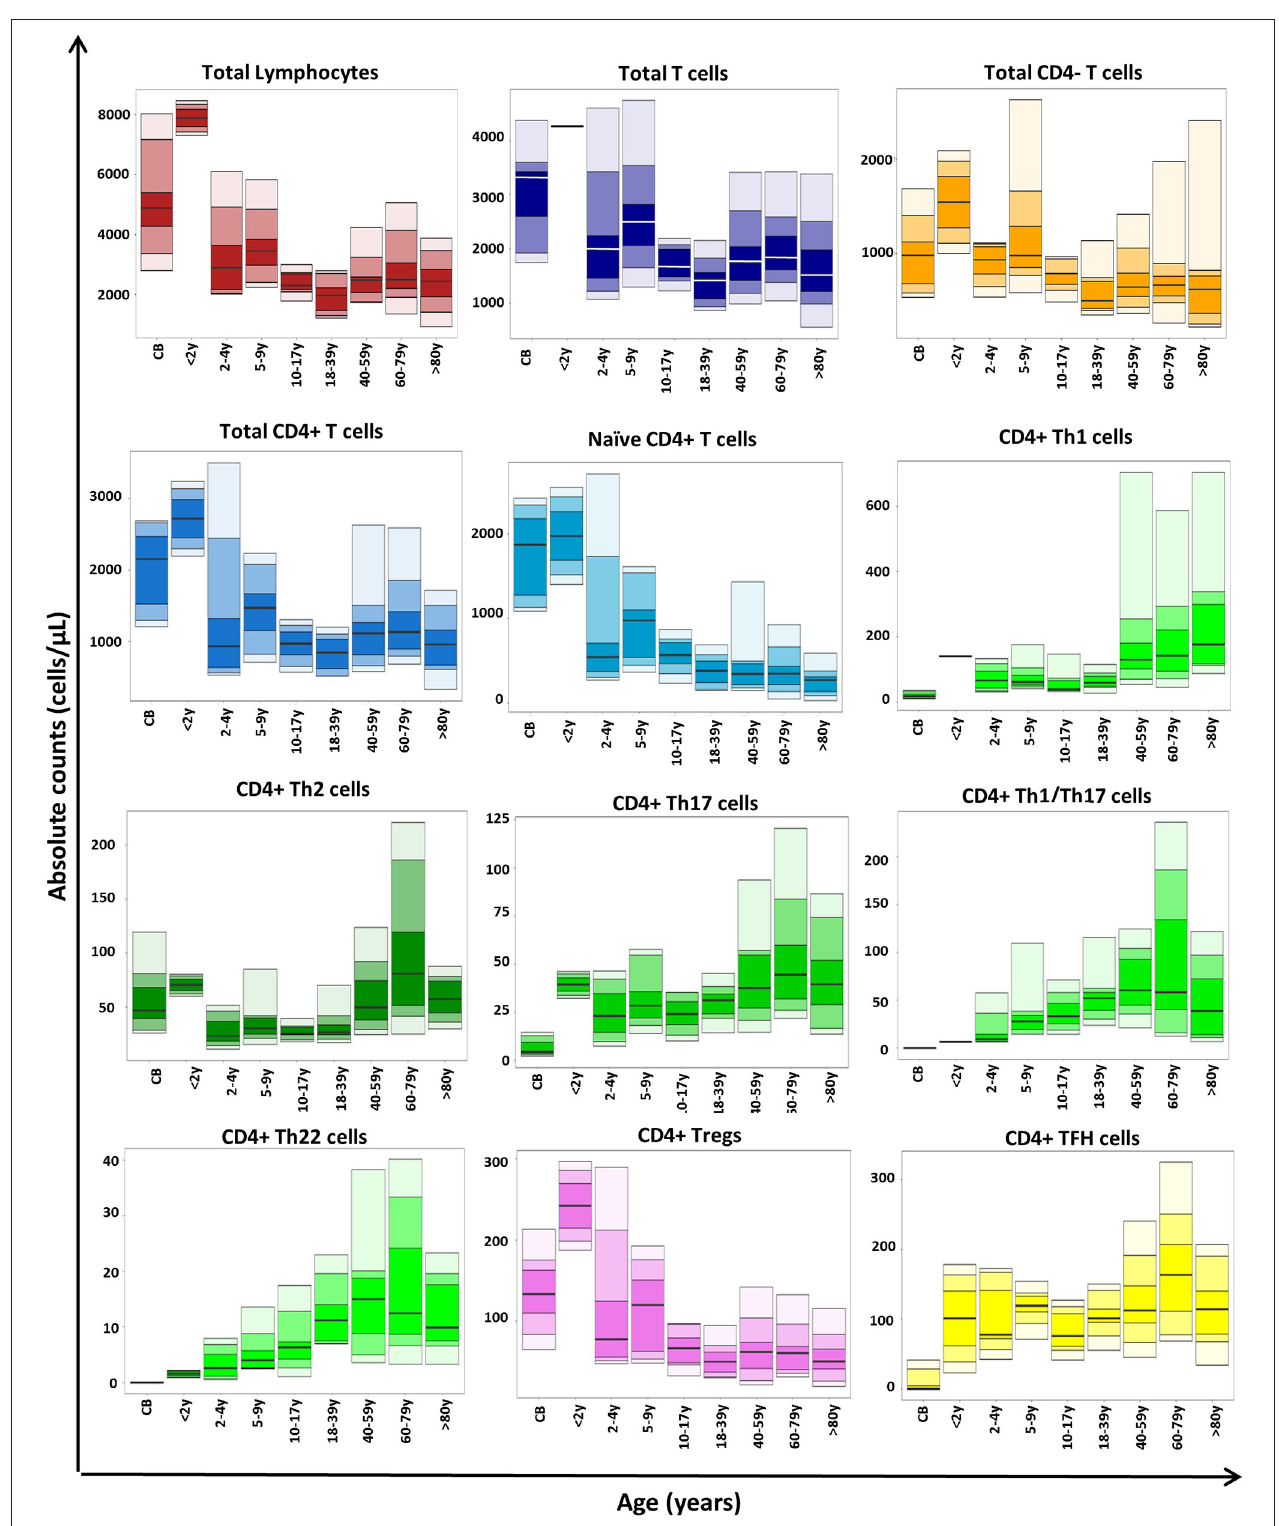
FIGURE 4 | Age-related distribution of CD4 + T-cell subsets in blood as assessed by the EuroFlow immune monitoring (IMM) TCD4 tube in 113 healthy controls. Absolute cell counts are displayed as bars representing median (p50 percentile), minimum, maximum, and p10, p25, p75, and p90 percentile values. All age groups, except children < 4 years included > 10